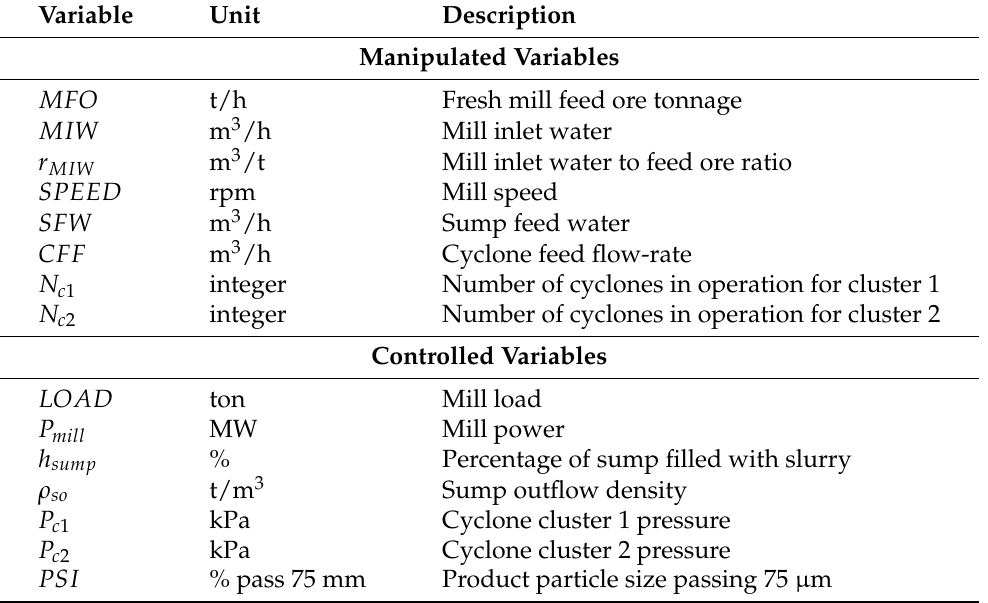
Table 1. Manipulated and controlled variables in the primary milling